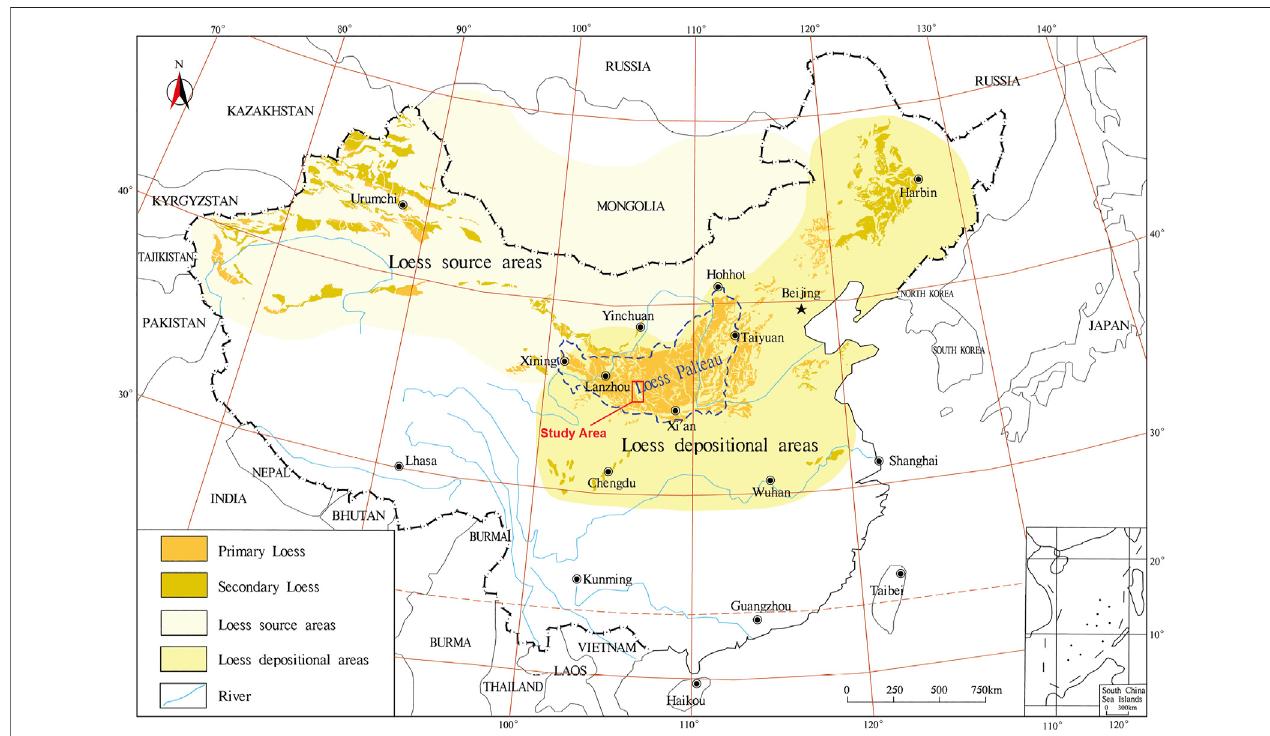
FIGURE 1 | Loess distribution and the Chinese Loess Plateau (Li et al., 2018).